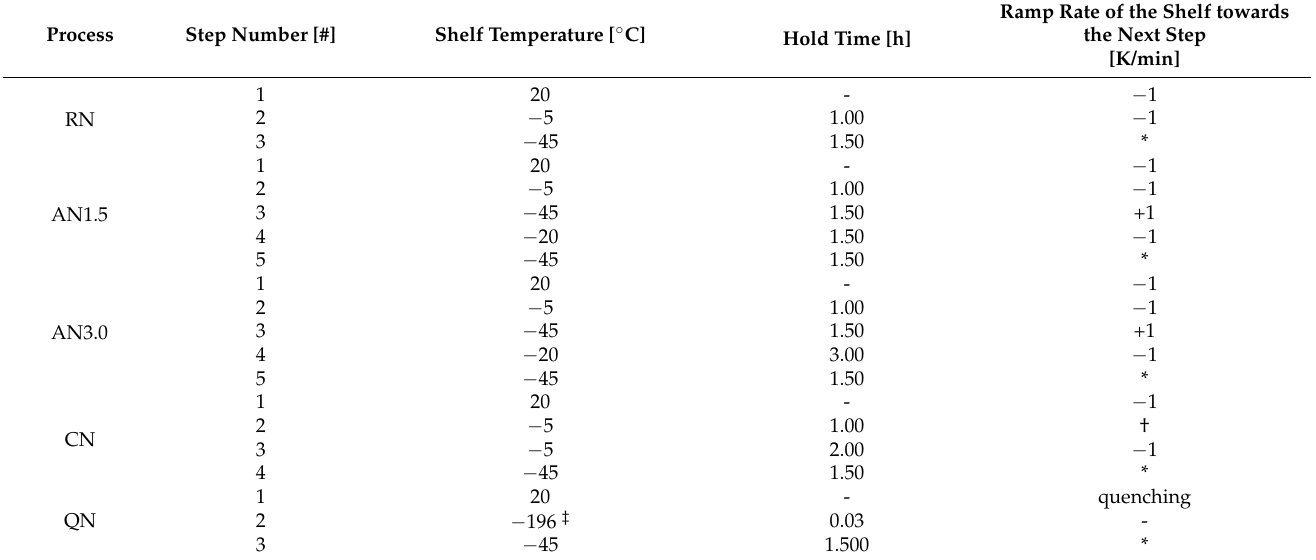
* indicates the start of primary drying.† Indicates the controlled nucleation process by introduction of ice fog. ‡ estimated temperature of a liquid nitrogen bath